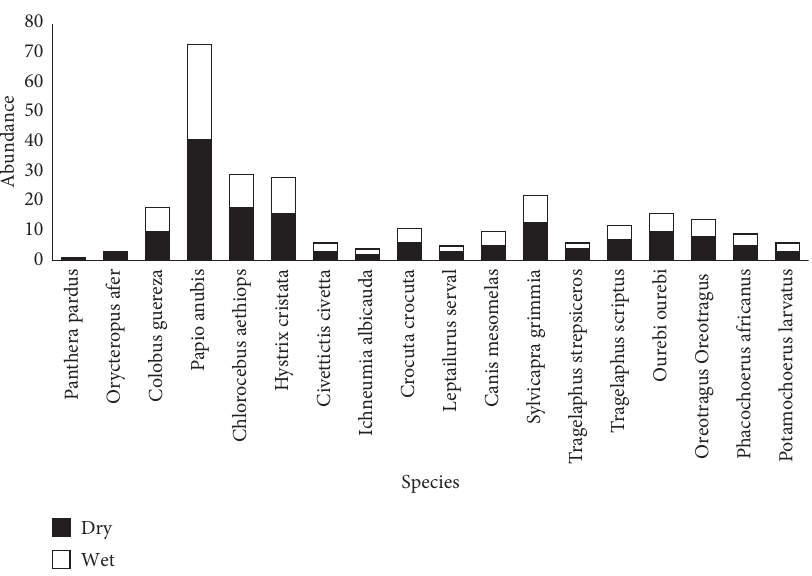
Figure 3: Seasonal variation in abundance of medium- and large-sized mammal